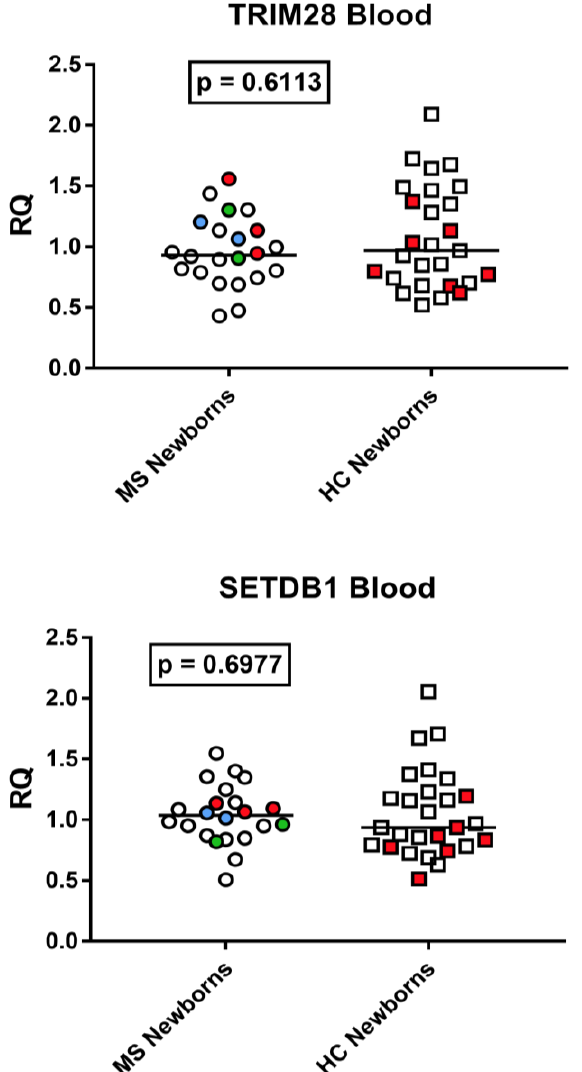
Figure 9. Expression of TRIM28 and SETDB1 in cord blood from 22 neonates born to 20 mothers with multiple sclerosis (MS) and from 27 neonates born to healthy control (HC) mothers. RQ: relative quantification. Circles and squares show the mean of three individual measurements; horizontal lines show the median values. Premature deliveries are shown in red; these include two pairs of twins in blue and green. Medians and IQR 25–75%: TRIM28: Group A (mothers with MS) 0.93, 0.79–1.13; Group B (unaffected mothers) 0.97, 0.72–1.42; SETDB1: Group A 1.04, 0.89–1.14; Group B 0.94,